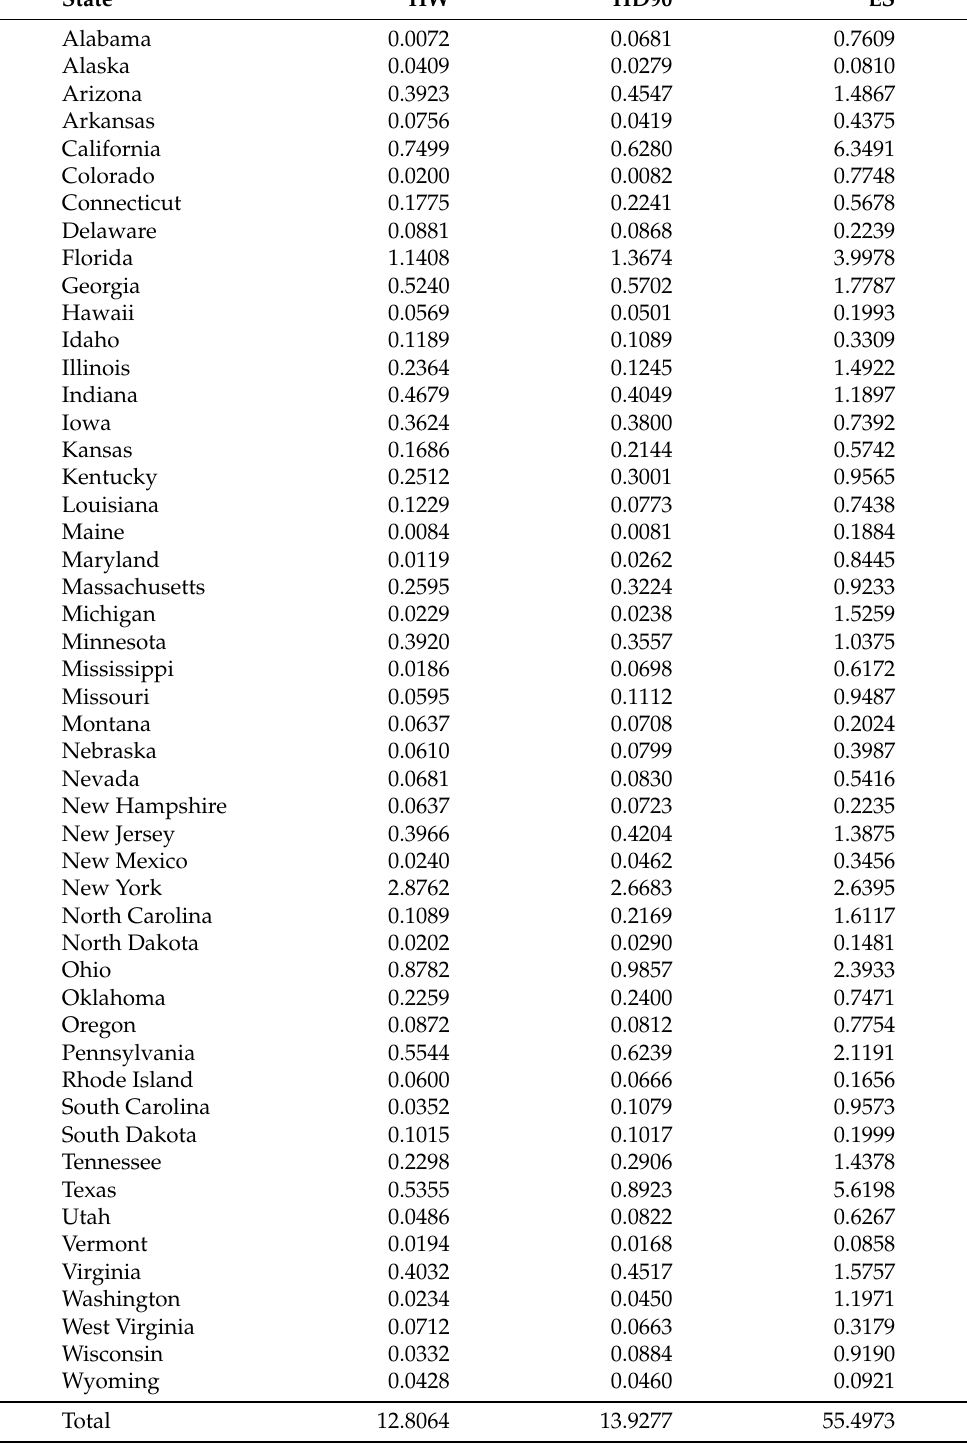
Table A1. Summary of the RMSE results by state across three different methods: Holt (HW) Trend, the Damping Holt (HD90) with φ = 0.90, and the exponential smoothing